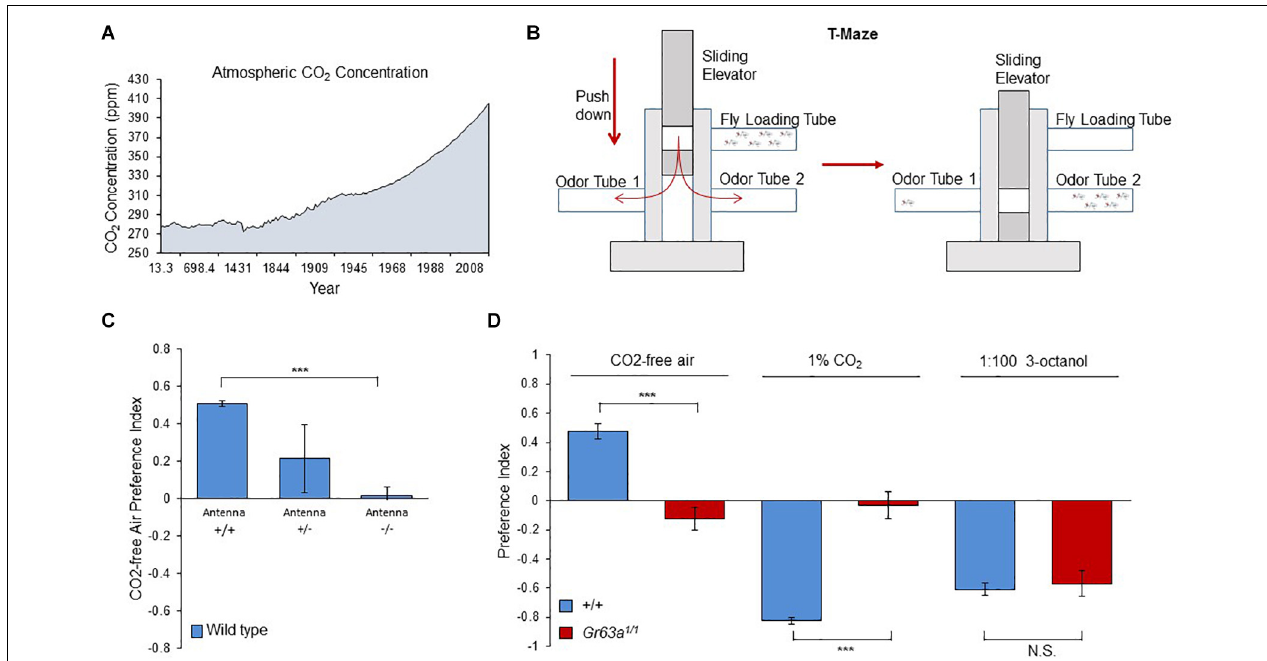
FIGURE 1 | Flies can detect and are attracted to sub-atmospheric CO 2 concentrations. (A) The change of atmospheric CO 2 concentration as a result of human activities. The graph is drawn by using the merged data of atmospheric CO 2 record based on ice core data before 1958 (MacFarling Meure et al., 2006) and yearly averages of direct observations from Mauna Loa and the South Pole after and including 1958 (Keeling et al., 2005). (B) The olfactory T-maze set-up used for olfactory choice behavior. (C) Response of antennaless wild-type flies to CO 2 -free air over the atmospheric air. Antennaless flies are no longer attracted to CO 2 -free air ( n = 4). (D) Response of gr63a 1 / 1 flies to CO 2 -free air, 1% CO 2 and 3-octanol. gr63a 1 / 1 flies showed no attraction to CO 2 -free air and no aversion to CO 2 , while OR-dependent 3-octanol sensitivity is still intact ( p = 0.0001, n = 6–8). Significance assessed by T-test ( p < 0.001). Error bars represent SEM. (ns > 0.05, * p ≤ 0.05, ** p ≤ 0.01, *** p ≤